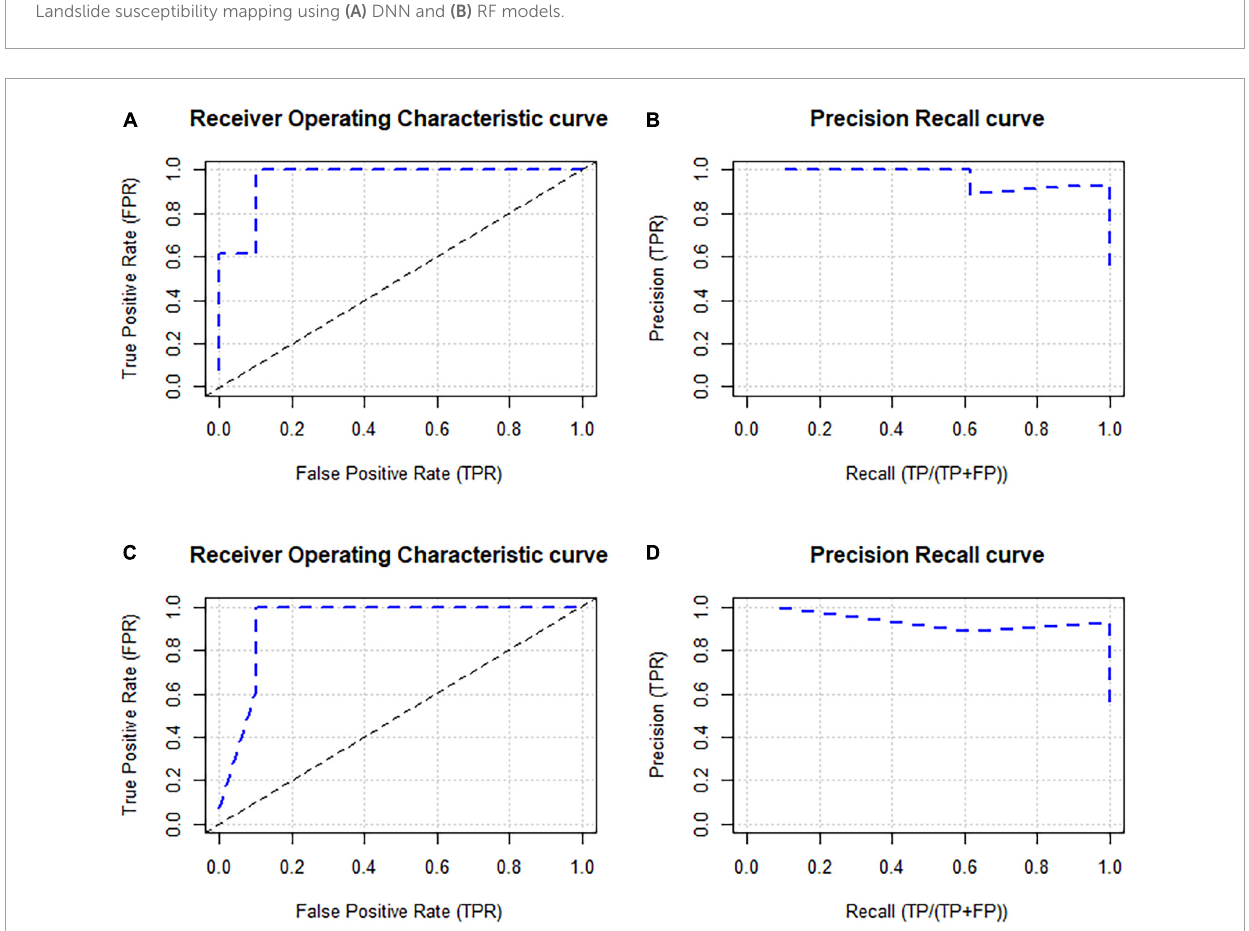
FIGURE12 The accuracy assessment of susceptibility model using AUC of ROC curve and precision an recall curves for DNN (A,B) and RF (C,D) .